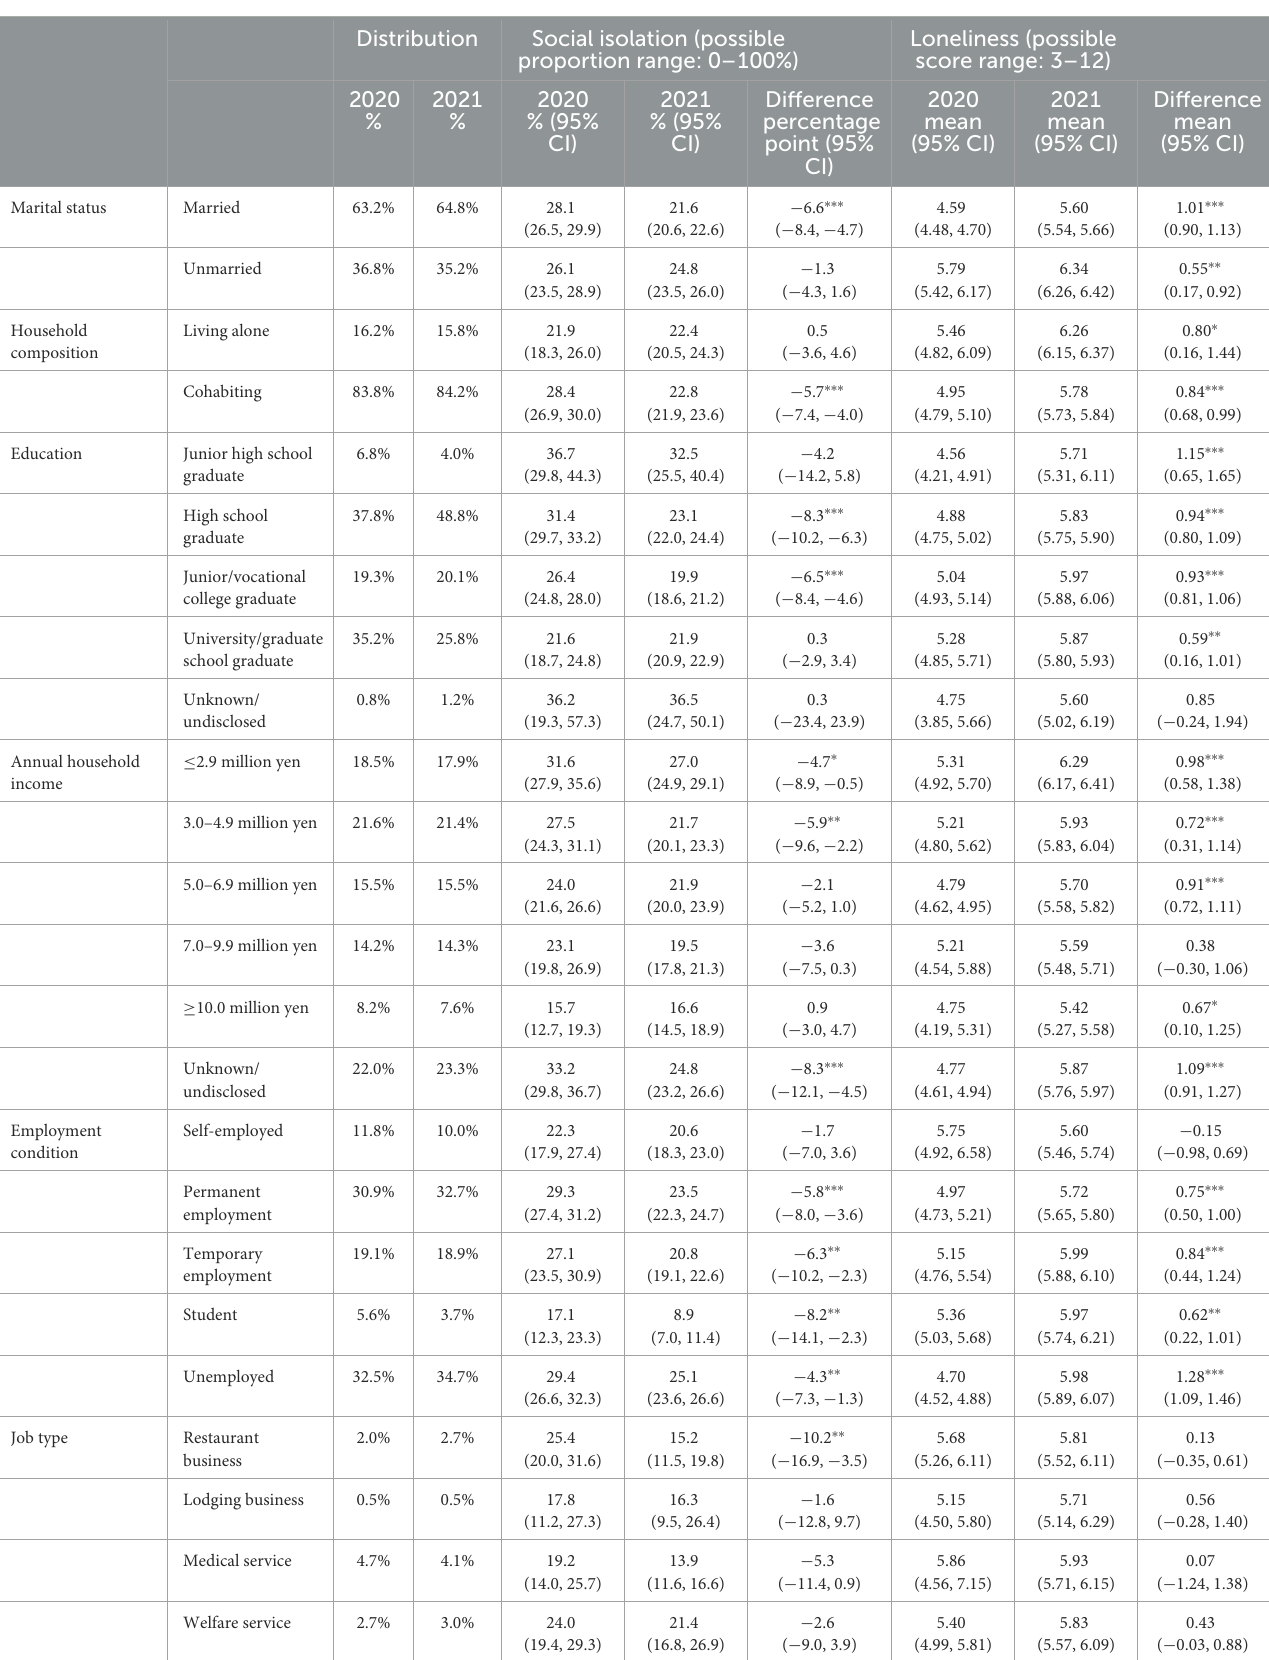
TABLE 2 The weighted prevalence of social isolation and loneliness by demographics and socioeconomic status. Distribution Social isolation (possible Loneliness (possible proportion range: 0–100%) score range: